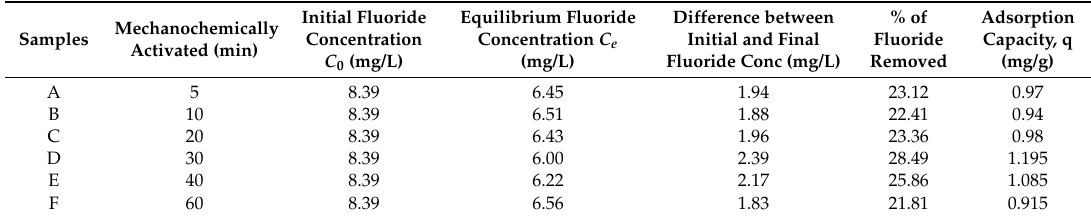
Table 5. Percent fluoride removal of the activated clays at different treatment times and their adsorption capacities.